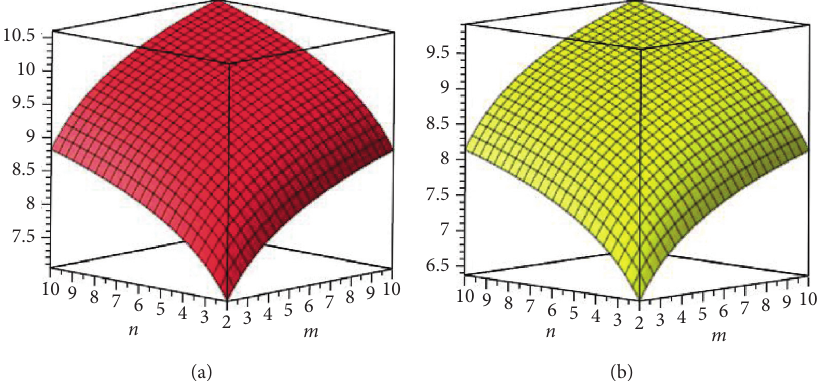
Figure 17: (a) The hyper-Zagreb entropy; (b) the forgotten